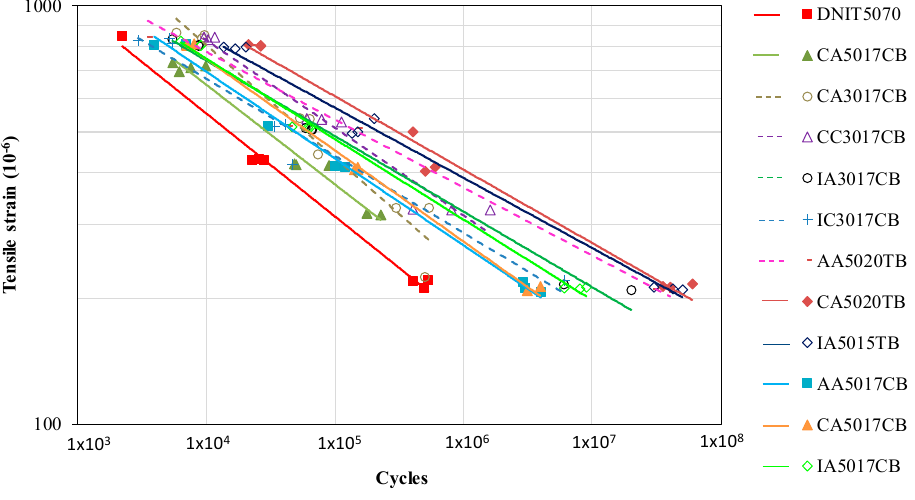
Figure 6. Fatigue curves of the mixtures. Table 10. Fatigue law parameters (20 °C; 10 Hz).